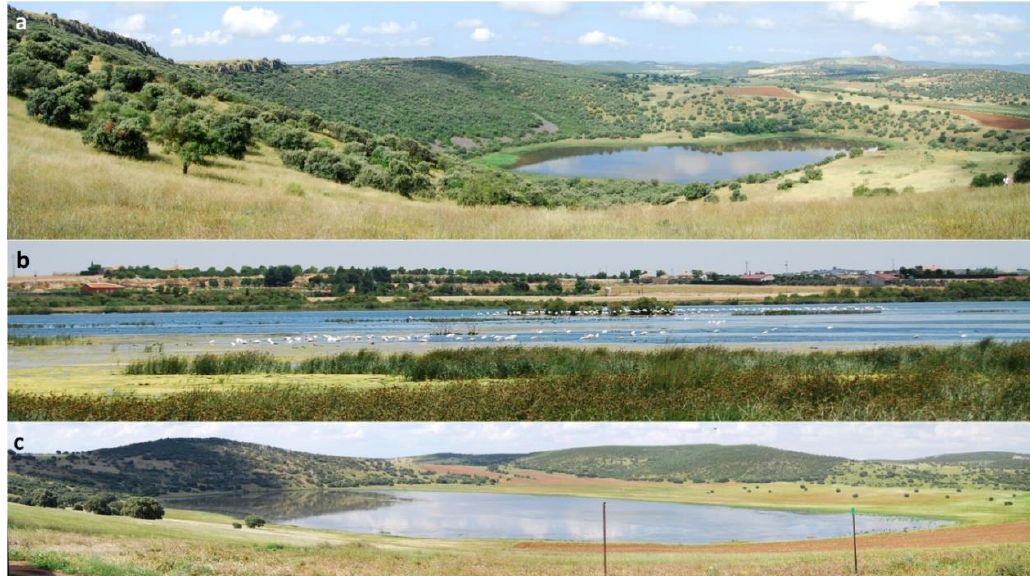
Figure 14. Examples of volcanic shallow lakes in Calatrava: ( a ) Volcano and Laguna de La Posadilla Natural Monument (Ciudad Real); ( b ) Laguna del Prado Natural Reserve (Pozuelo de Calatrava) and lots of flamingos; ( c ) Los Lomillos, Calatrava Massif Natural Monument (Argamasilla de Calatrava).